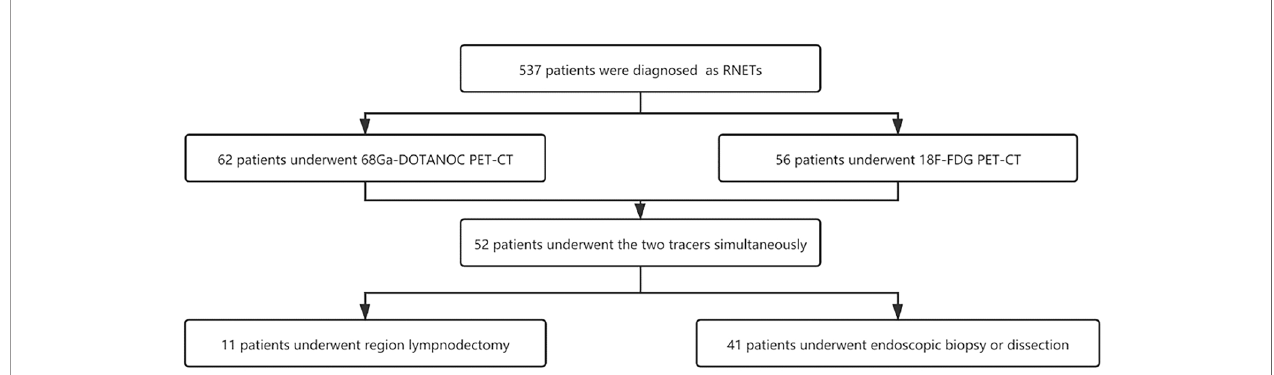
FIGURE 1 | The fl owchart of study